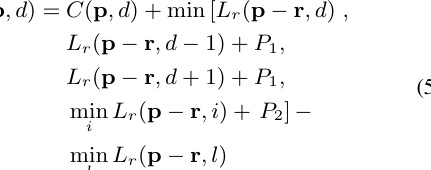
Figure 2: Matching costs, aggregated path costs, and sum costs for the pixel p = [183; 278] of the Teddy image calculated with census transform and